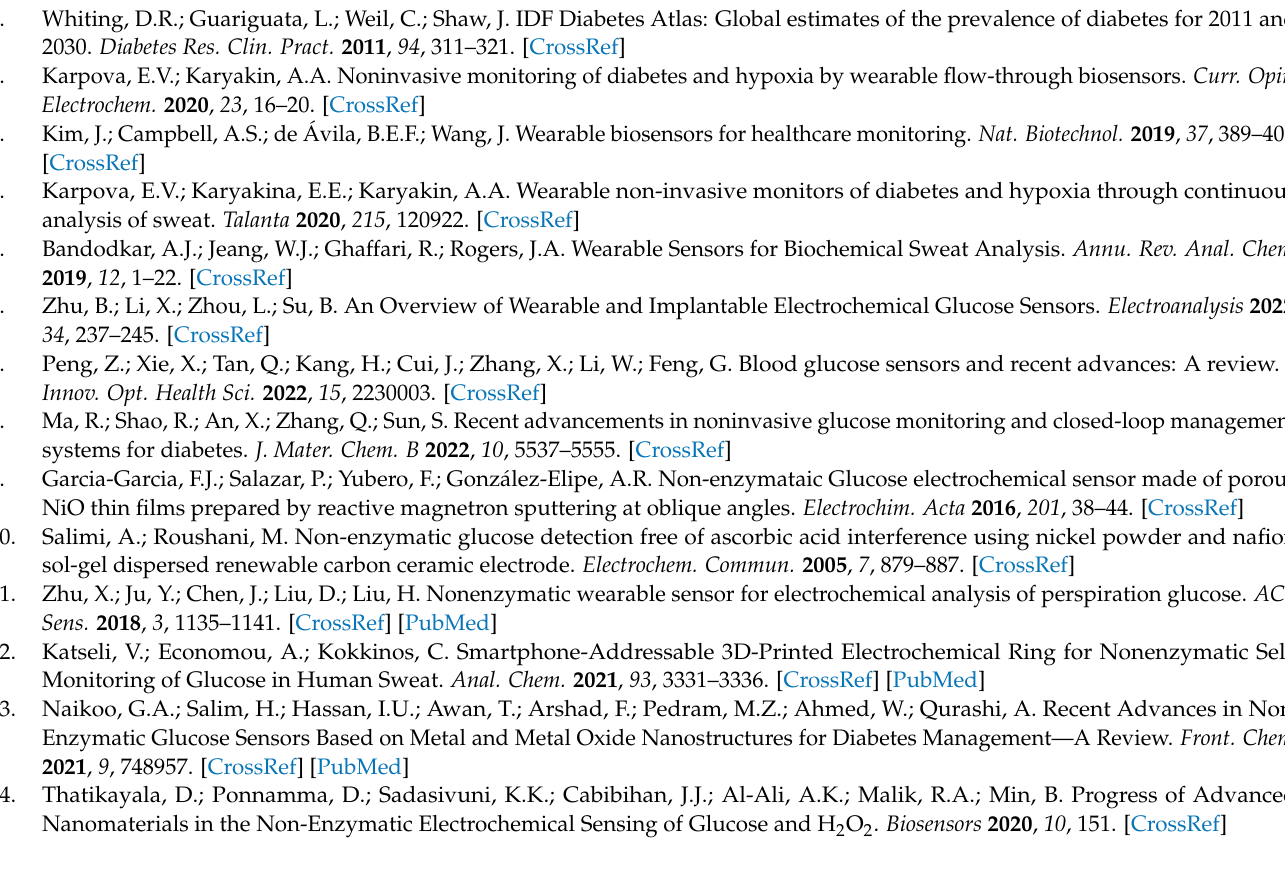
(shown as blue dashes in Figure 1) from the Rietveld Analysis of [Fe 3 O(PhCO 2 ) 6 (H 2 O) 3 ] · PhCO 2 ; Figure S1: The IR spectrum (ATR) of [Fe 3 O(PhCO 2 ) 6 (H 2 O) 3 ] · PhCO 2 in the 450–4000 cm − 1 range; Figure S2: Image of [Fe 3 O(PhCO 2 ) 6 (H 2 O) 3 ] · PhCO 2 dispersed in water on a glass slide; Figure S3: Histogram of particle sizes ranging between 50 and 230 µ m (black bars), and Gaussian fit (red line); Figure S4: Thermogravimetric analysis (TGA) graph of [Fe 3 O(PhCO 2 ) 6 (H 2 O) 3 ] · PhCO 2 in the 25–800 ◦ C temperature range. Reference [44] is cited in the supplementary